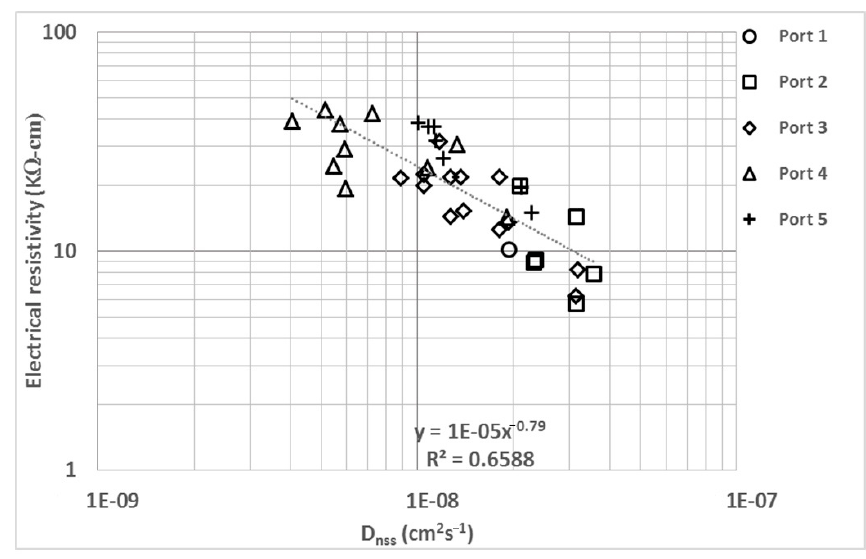
Figure 5. Electrical resistivity (ER) vs. non-steady state diffusion coefficient (D nss ).